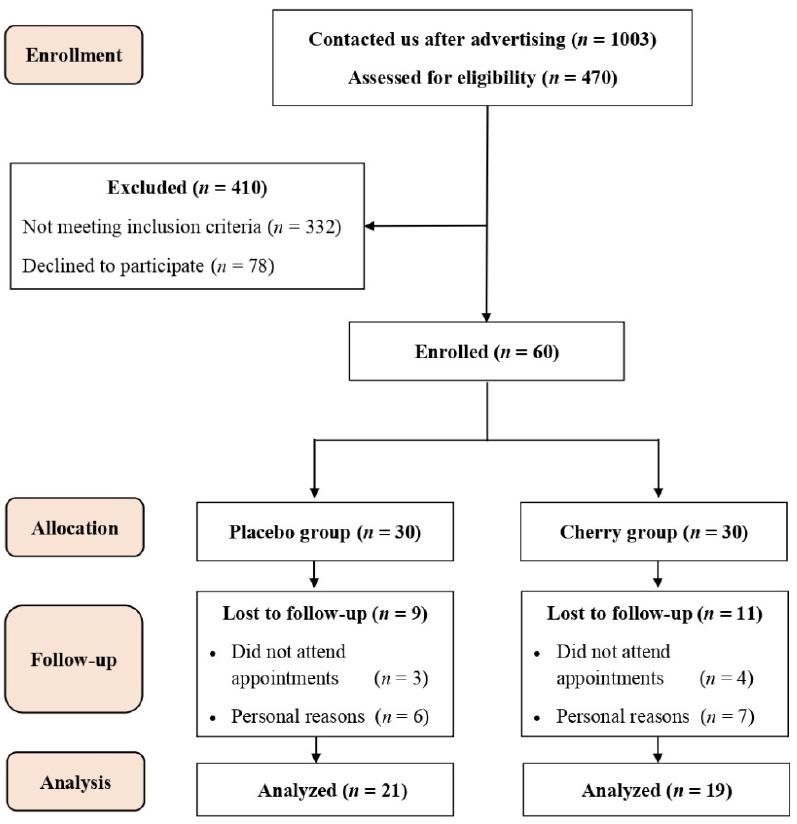
Figure 2. Participant flow diagram for recruitment, randomization, and data analysis.